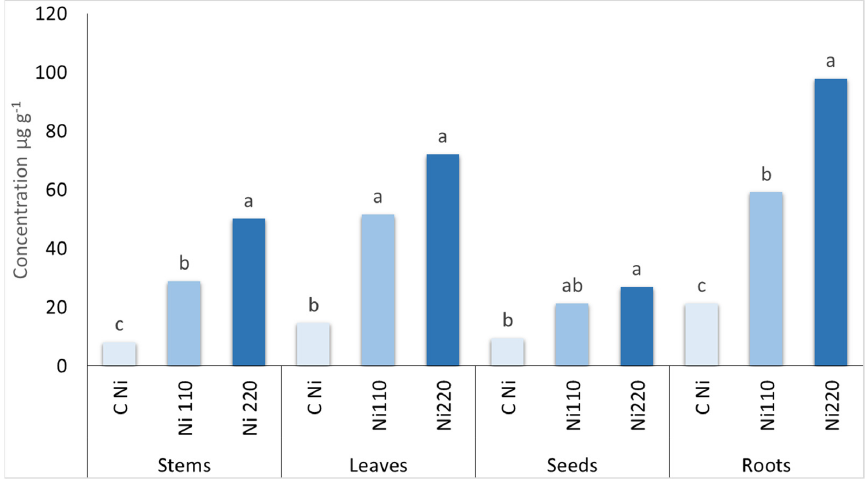
Figure 6. Concentration of Ni ( µ g g − 1 ) in the different fractions of the plants as average of two years. The multiple comparisons between the means have been performed within the plant fractions. Values with different letters indicate statistical significance (according to HSD at p ≤ 0.05).